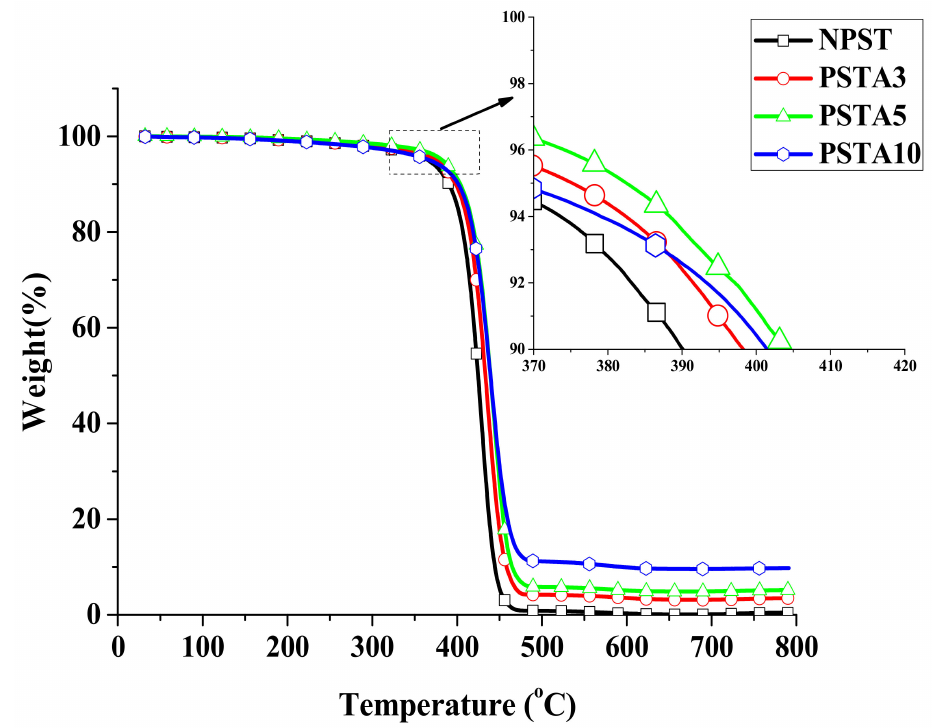
Figure 3. The relative weight change curves of Type II samples from TGA